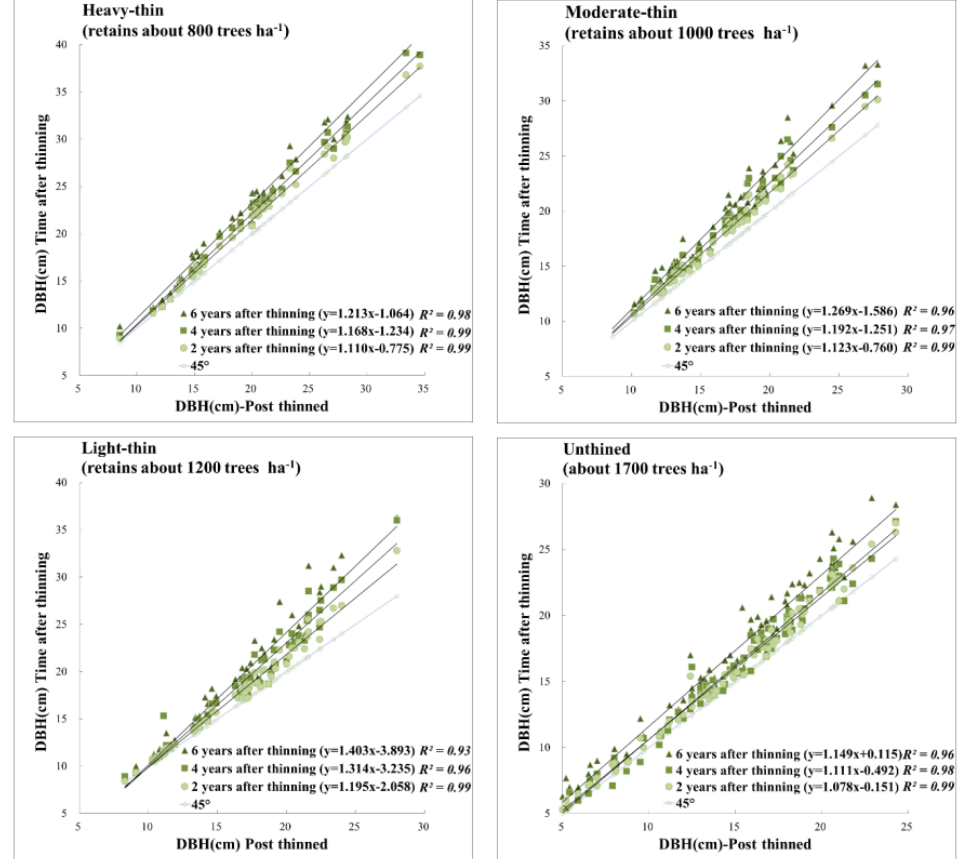
Figure 2. Scattering of DBH at 2–6 years under different thinning intensities of 14-year old mahogany Note: 45 ◦ line is the year after thinning ( X -axis)—years after thinning ( Y -axis).